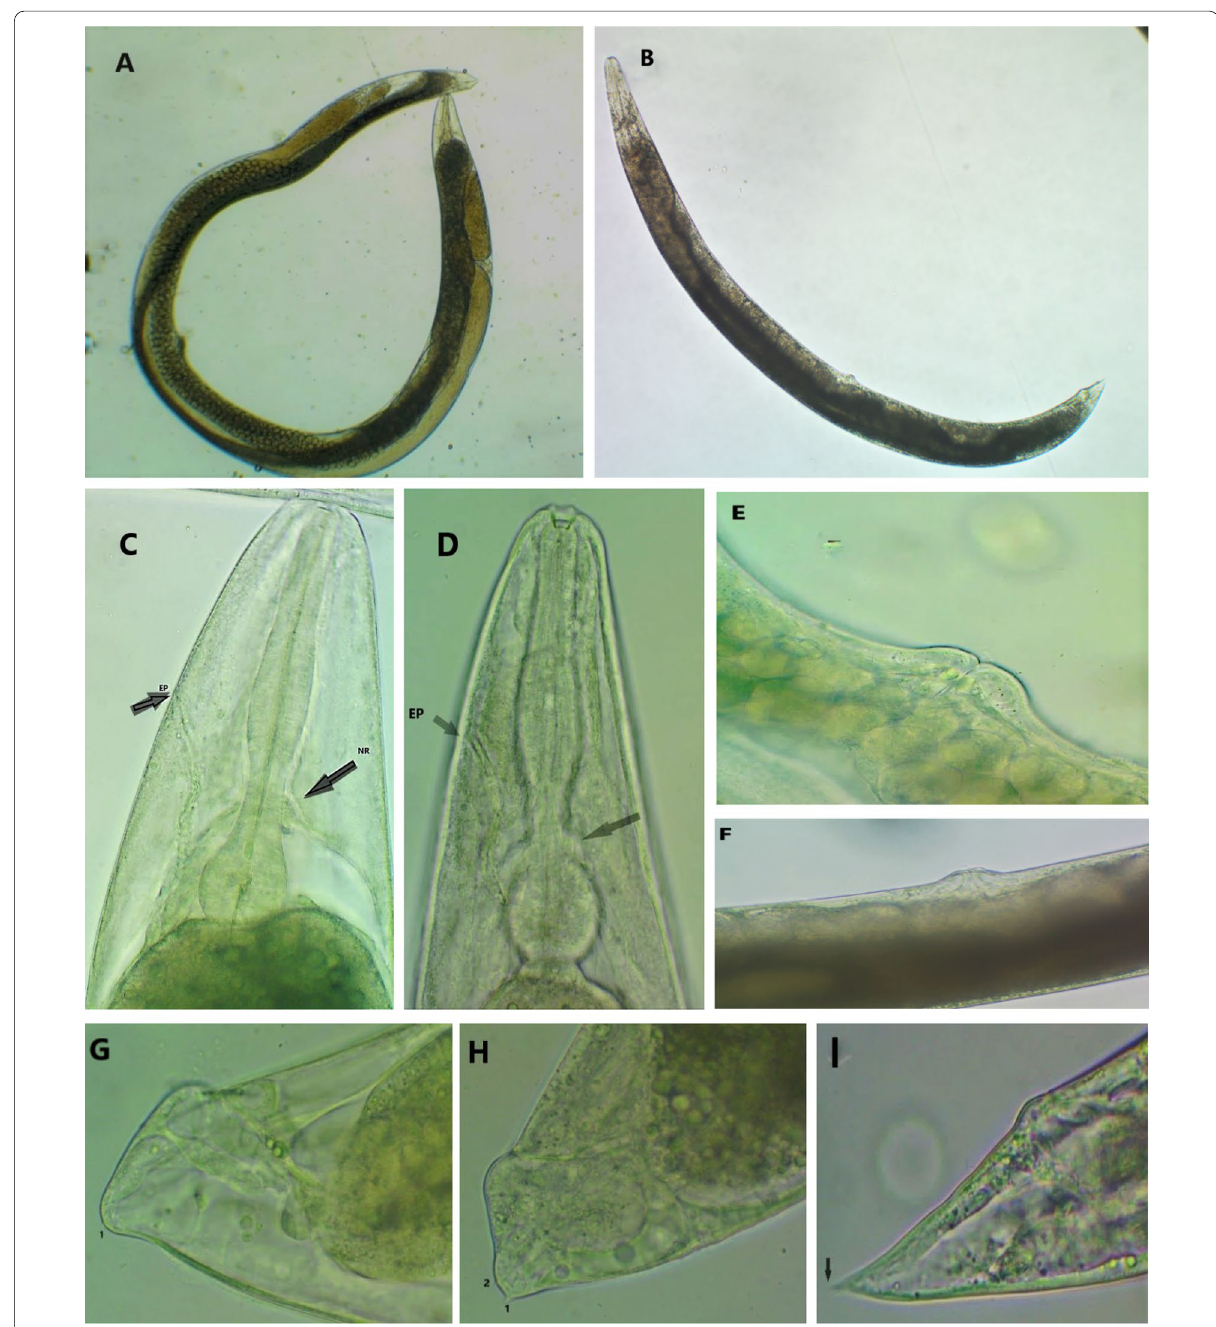
Fig. 3 Steinernema affine female. A : first-generation entire body B : second-generation entire body. C : anterior portion, right arrow refer to nerve ring position and left arrow refer to excretory pore of first generation. D : right arrow refers to nerve ring which located toward the anterior portion of basal bulb. E : vulva of first generation female . F : vulva of second-generation female . G, H : tail region with one and two papilla structure of first generation, respectively. I : tail region with papilla structure of second generation. Scale bar: A 4245 µm. B 1460 µm, C: EP 122 µm, = = = NR 160 µm. D: NR 167 µm, EP 118 µm. F 0.9 µm. G 1 µm. H 1 2.1 µm, 2 1.2. I 4.3 µm. E 19 µm. F 2 µm. G:1 2.1 µm, 2 1.3 µm. = = = = = = = = = = = = = H: 4.3 µm. I 0.9 =